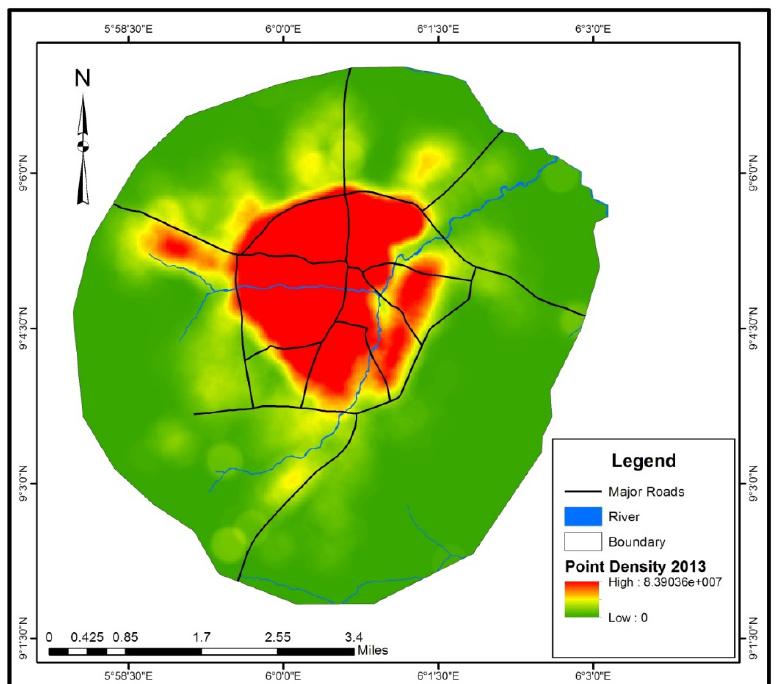
Fig. 4. Spatial pattern of residential density in the study area in 2013 (Developed by the authors,